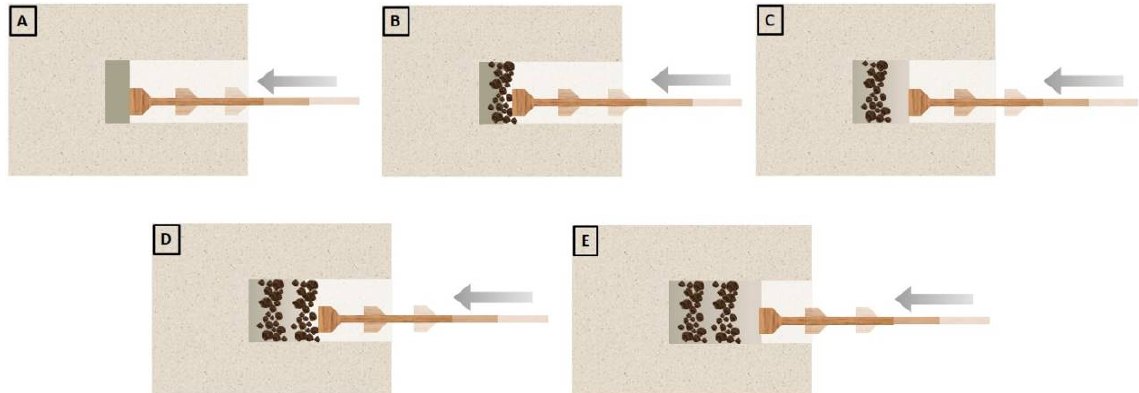
Figure 3 – Dry pack filling procedure